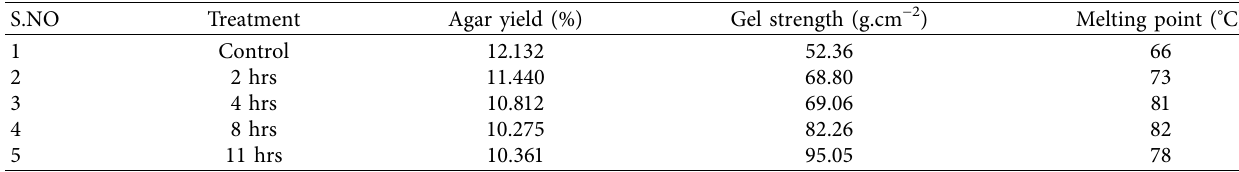
Table 6: Quality of agar gel from Gracilaria edulis